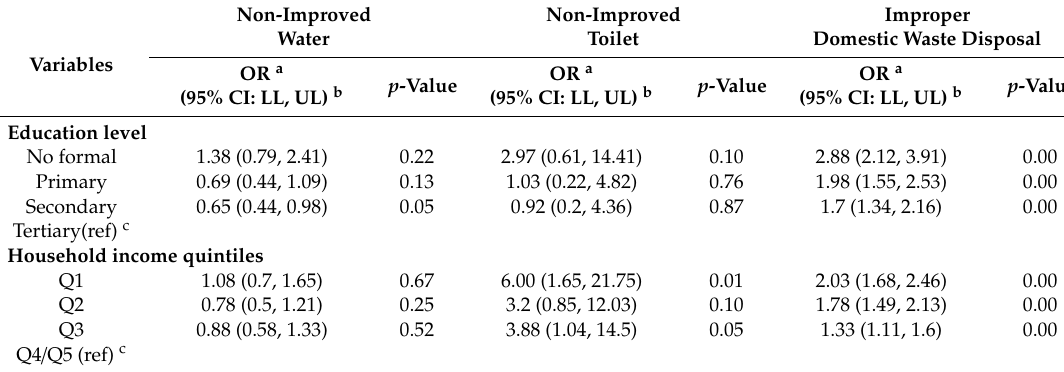
Table 1. Odds ratio of using non-improved drinking water sources, toilet types and improper domestic waste